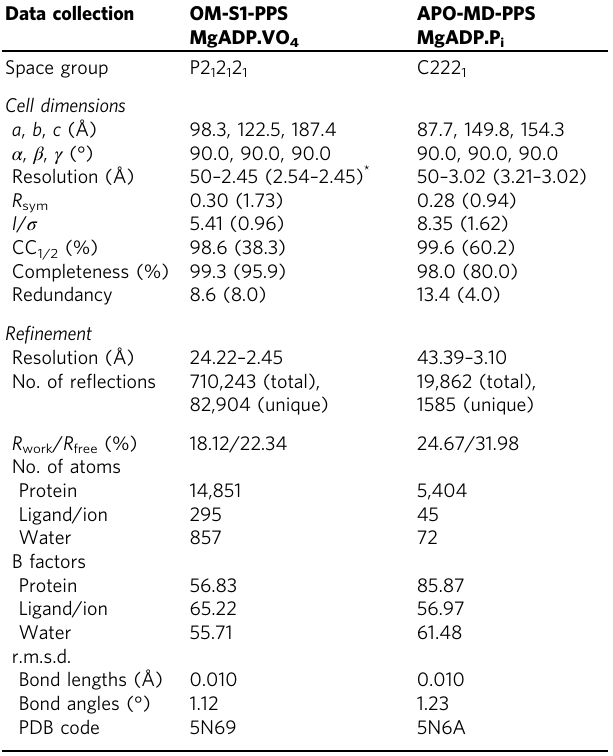
Table 1 Data collection and re fi nement